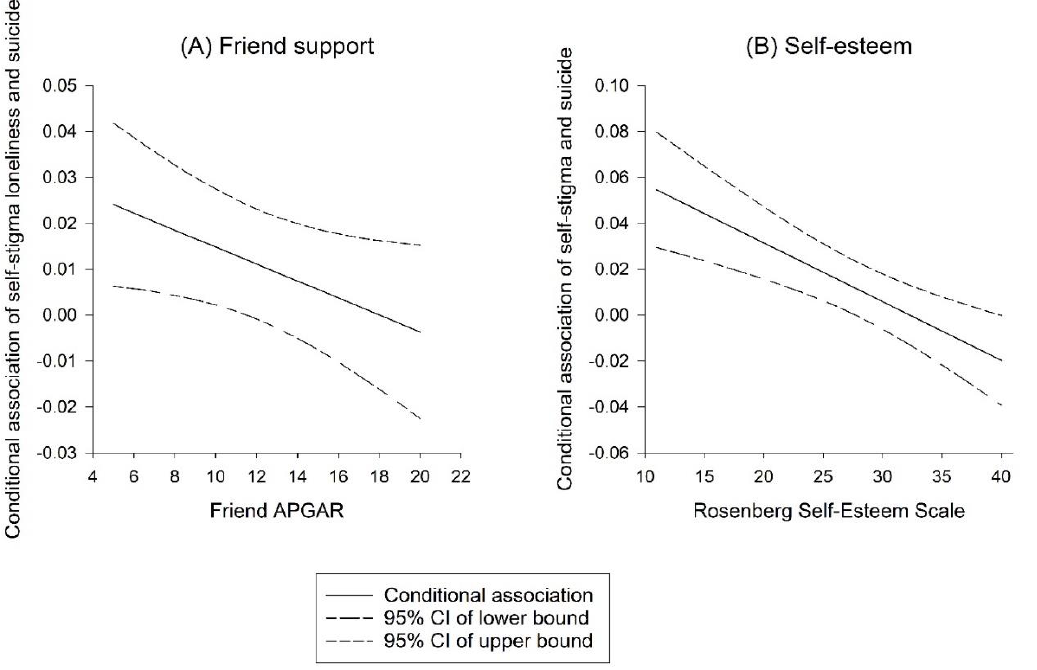
Figure 1. Moderating effects of perceived support from friends and self-esteem on the association between self-stigma and suicide risk among individuals with schizophrenia.